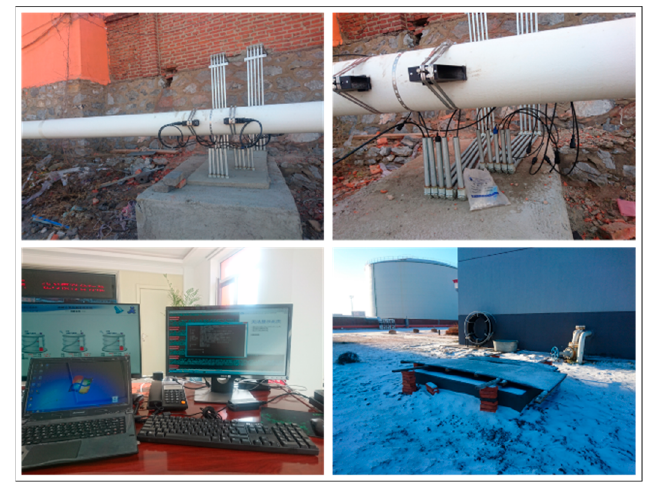
Figure 4. Experimental site.